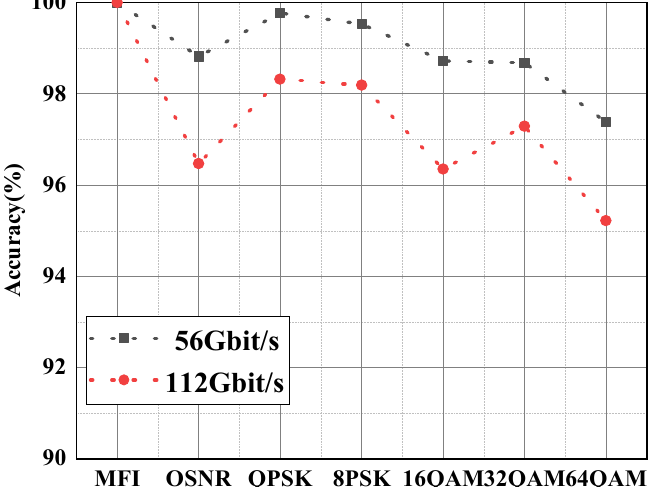
Figure 15. Accuracies for MFF-Net trained on data from 56 Gbit/s and 112 Gbit/s.